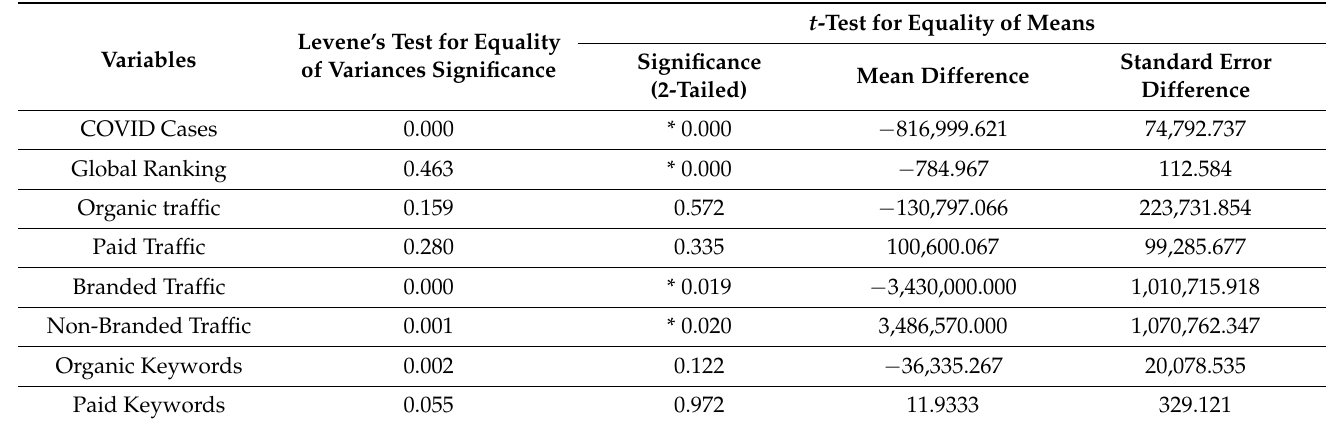
Table 5. Independent sample t -tests results within the COVID 2nd 12-month period data set.